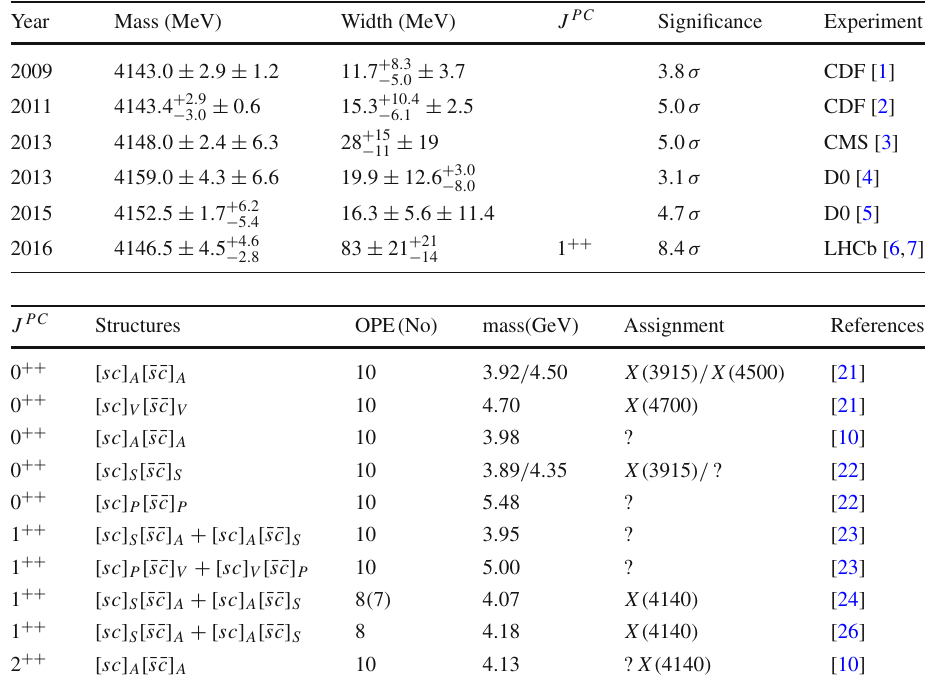
Table 1 The mass, width, J PC of the X ( 4140 ) from the different experiments